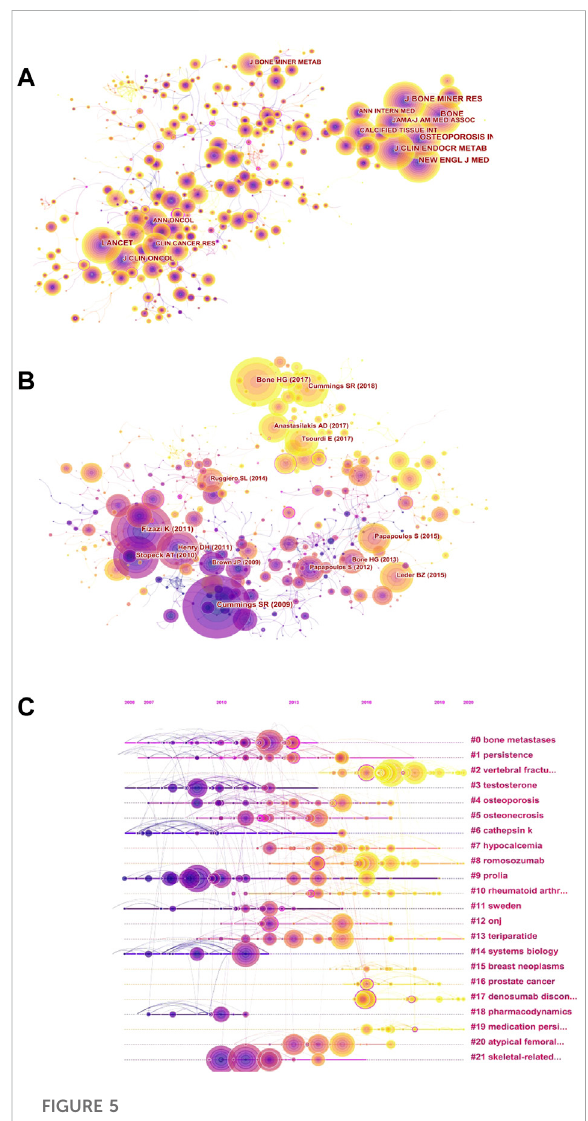
FIGURE 5 Visual network diagram of co-citation. (A) Co-citation network of cited journals in denosumab from 2011 to 2021. The nodes represent cited journals, and the lines represent co-citation relationships.Differentcolorsinthenodesrepresentdifferent years. The purple outer circle represents higher centrality. (B) Co- citation network of references in denosumab from 2011 to 2021. The nodes represent references, and the lines represent co- citation relationships. Different colors in the nodes represent differentyears.Thepurpleoutercirclerepresentshighercentrality. (C) Timeline view based on the abstracts of the references in the denosumab fi eld from 2011 to 2021. The nodes represent references, and the position on the horizontal line represents the year the reference was published. The lines represent co-citation relationships. Different colors in the nodes represent different years. The purple outer circle represents higher